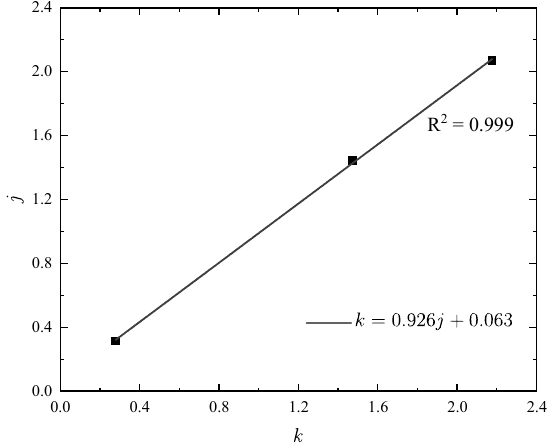
Figure 20. Curves of parameters k vs. j in the joint surface wear fitting formula.